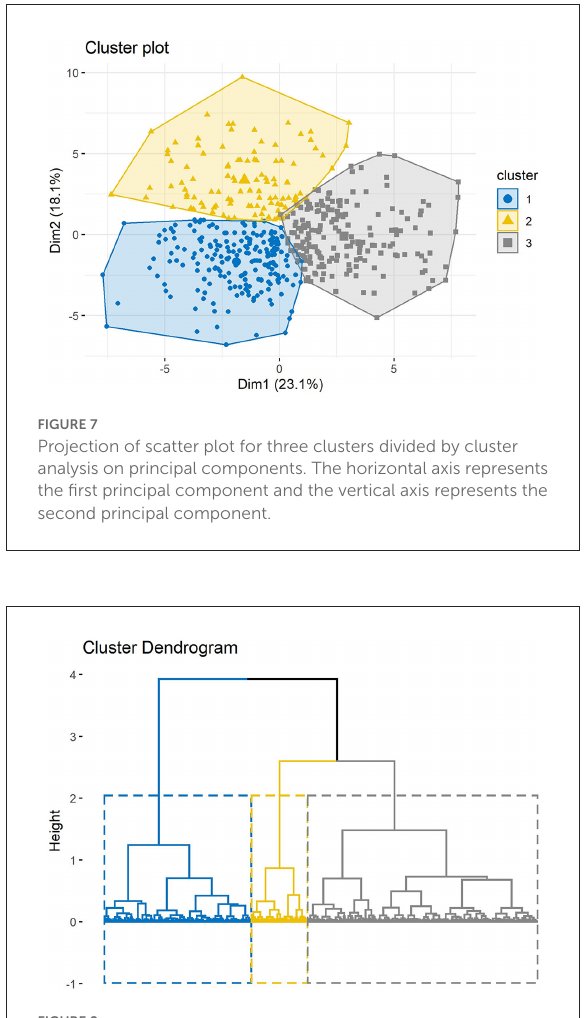
FIGURE8 Cluster dendrogram. The height of the branches indicates the distance or dissimilarity between clusters.